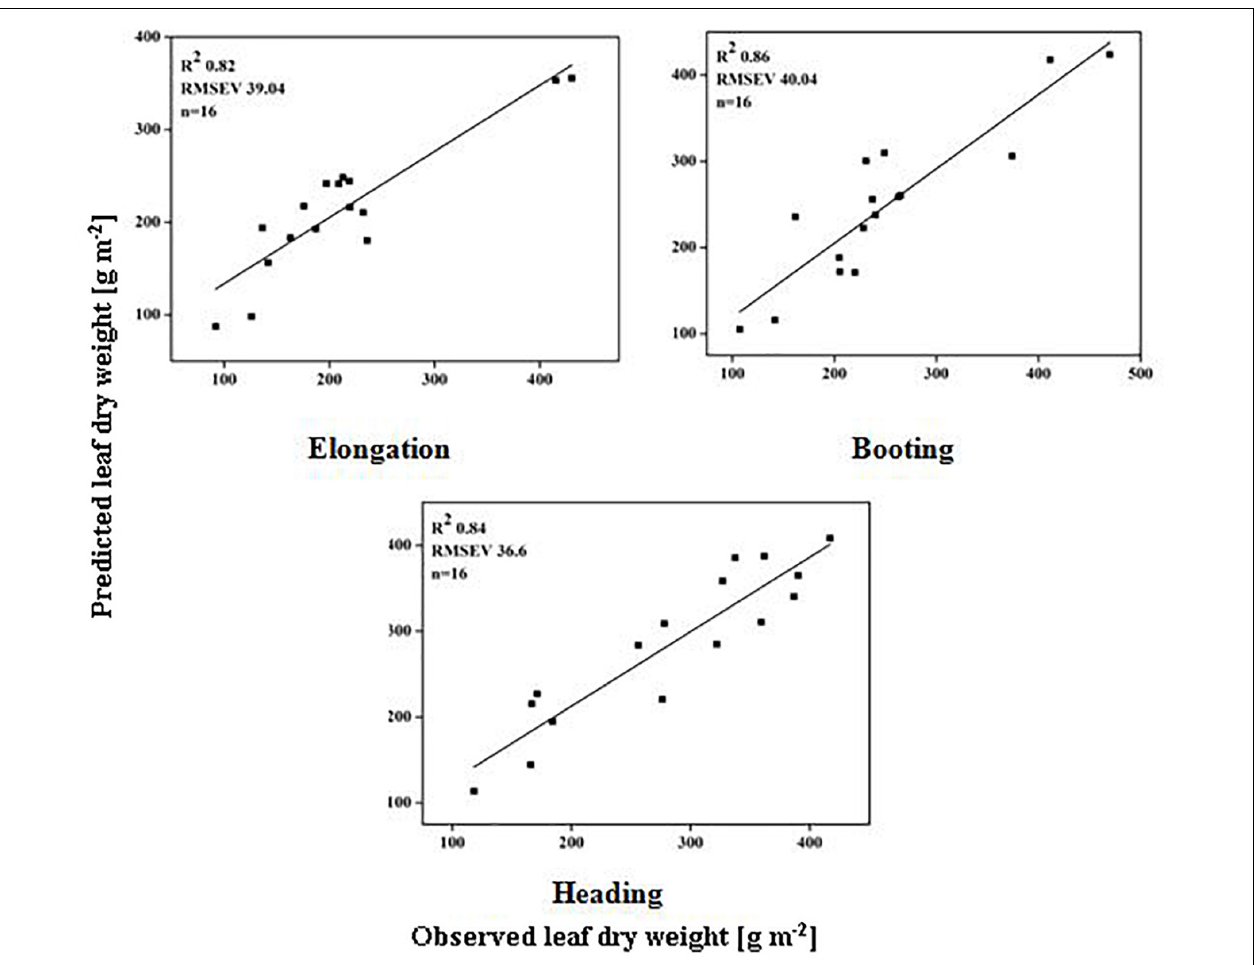
yield (Ata-Ul-Karim et al., 2016, 2017b). The results of this CSR over different phenological stages formulate several narrow band HVIs that have the potential to estimate crop growth